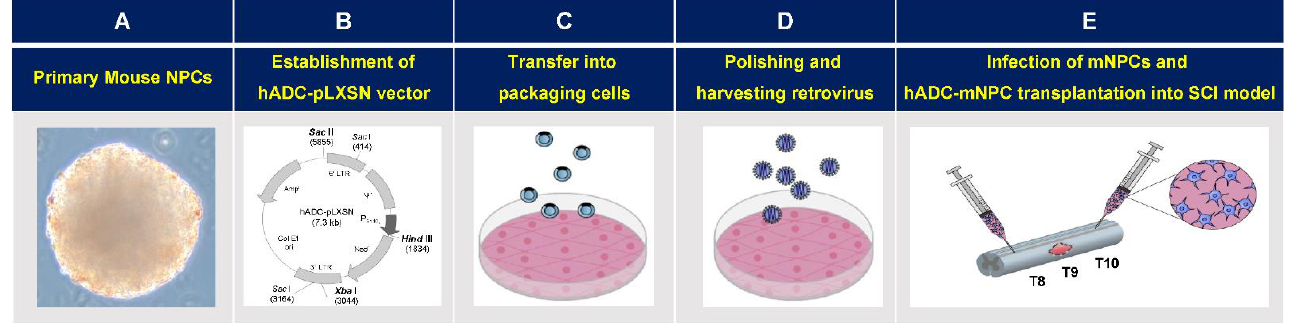
Figure 8. Retroviral vector and hADC-mNPCs therapy bioprocessing for spinal cord injury (SCI). ( A ) Isolation of primary mouse neural precursor cells (mNPCs) from brains of ICR mouse embryos, followed by neurosphere cultivation. ( B ) Full-length hADC cDNA was PCR-amplified and ligated to recombinant retroviral expression vector pLXSN. ( C ) The hADC-expressing pLXSN plasmids and empty pLXSN plasmids containing neomycin resistance genes were transfected using Lipofectamine 2000 into the retroviral packaging cell line PT-67. ( D ) Supernatants containing hADC genes and empty retrovirus pLXSN were infected to NIH-3T3 cells using polybrene reagent to determine viral titers. Retrovirus containing human arginine decarboxylase genes (hADC) were transfected into mouse neural precursor cells (mNPCs). ( E ) Spinal cords were compressed at thoracic vertebra (T) 9 (indicated by irregular pink shape representing glial scar). The experiments used mNPCs infected with hADC (hADC-mNPCs), mNPCs infected with pLXSN (pLXSN-mNPCs), and non-infected control mNPCs. Mice with SCI were randomly divided into four experimental groups and cells were transplanted into two regions—rostral (Thoracic 8) and caudal (Thoracic 10)—from the lesion site (T9) at 1 week after SCI.